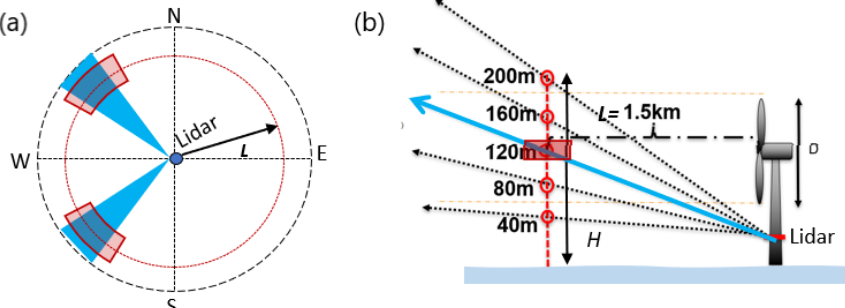
Figure 3. (a) Sketch of scanning for partial VAD. Shaded areas in blue represent areas where the wind is interrogated continuously. Areas in red represent the volumes where data for VAD are selected. (b) Sketch of the vertical profile of the wind speed and wind direction at the five target heights selected in this campaign, where L is the distance from the lidar system to the measurement location.